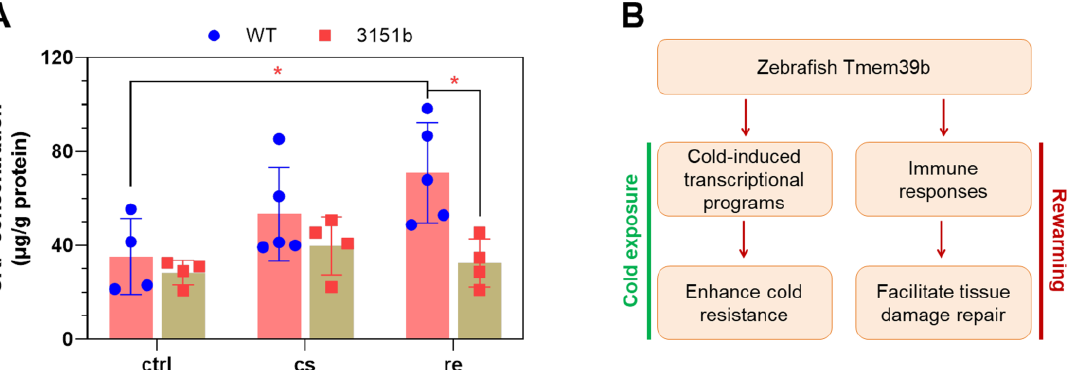
Figure 9. Zebrafish Tmem39b regulates the production of C-reactive protein (CRP) during rewarming and a working model for Tmem39b’s function in determining cold resilience. ( A ) Deficiency of tmem39b attenuates the up-regulation of CRP in zebrafish larvae during the recovery phase following cold exposure. CRP concentration is normalized as µ g/g protein. All the data points are shown. *, p ≤ 0.05. ( B ) A working model for zebrafish Tmem39b’s